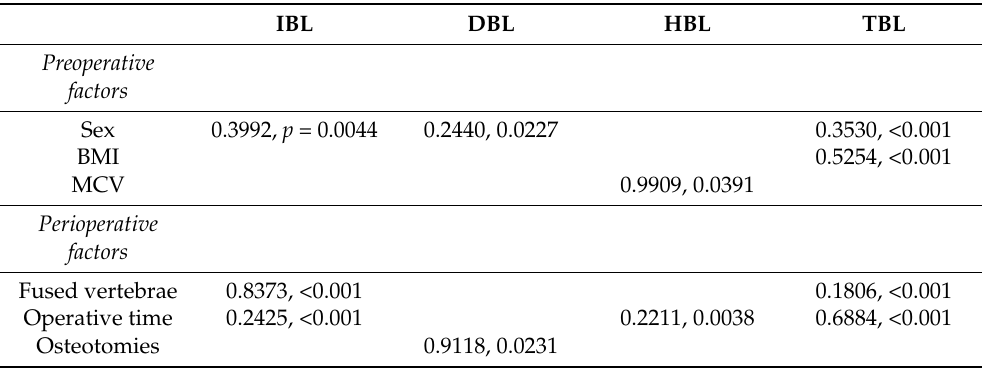
Table 3. Multiple linear regression analysis for each type of bleeding in AIS, and correlation coeffi- cients and p -values for each significant factor and bleeding